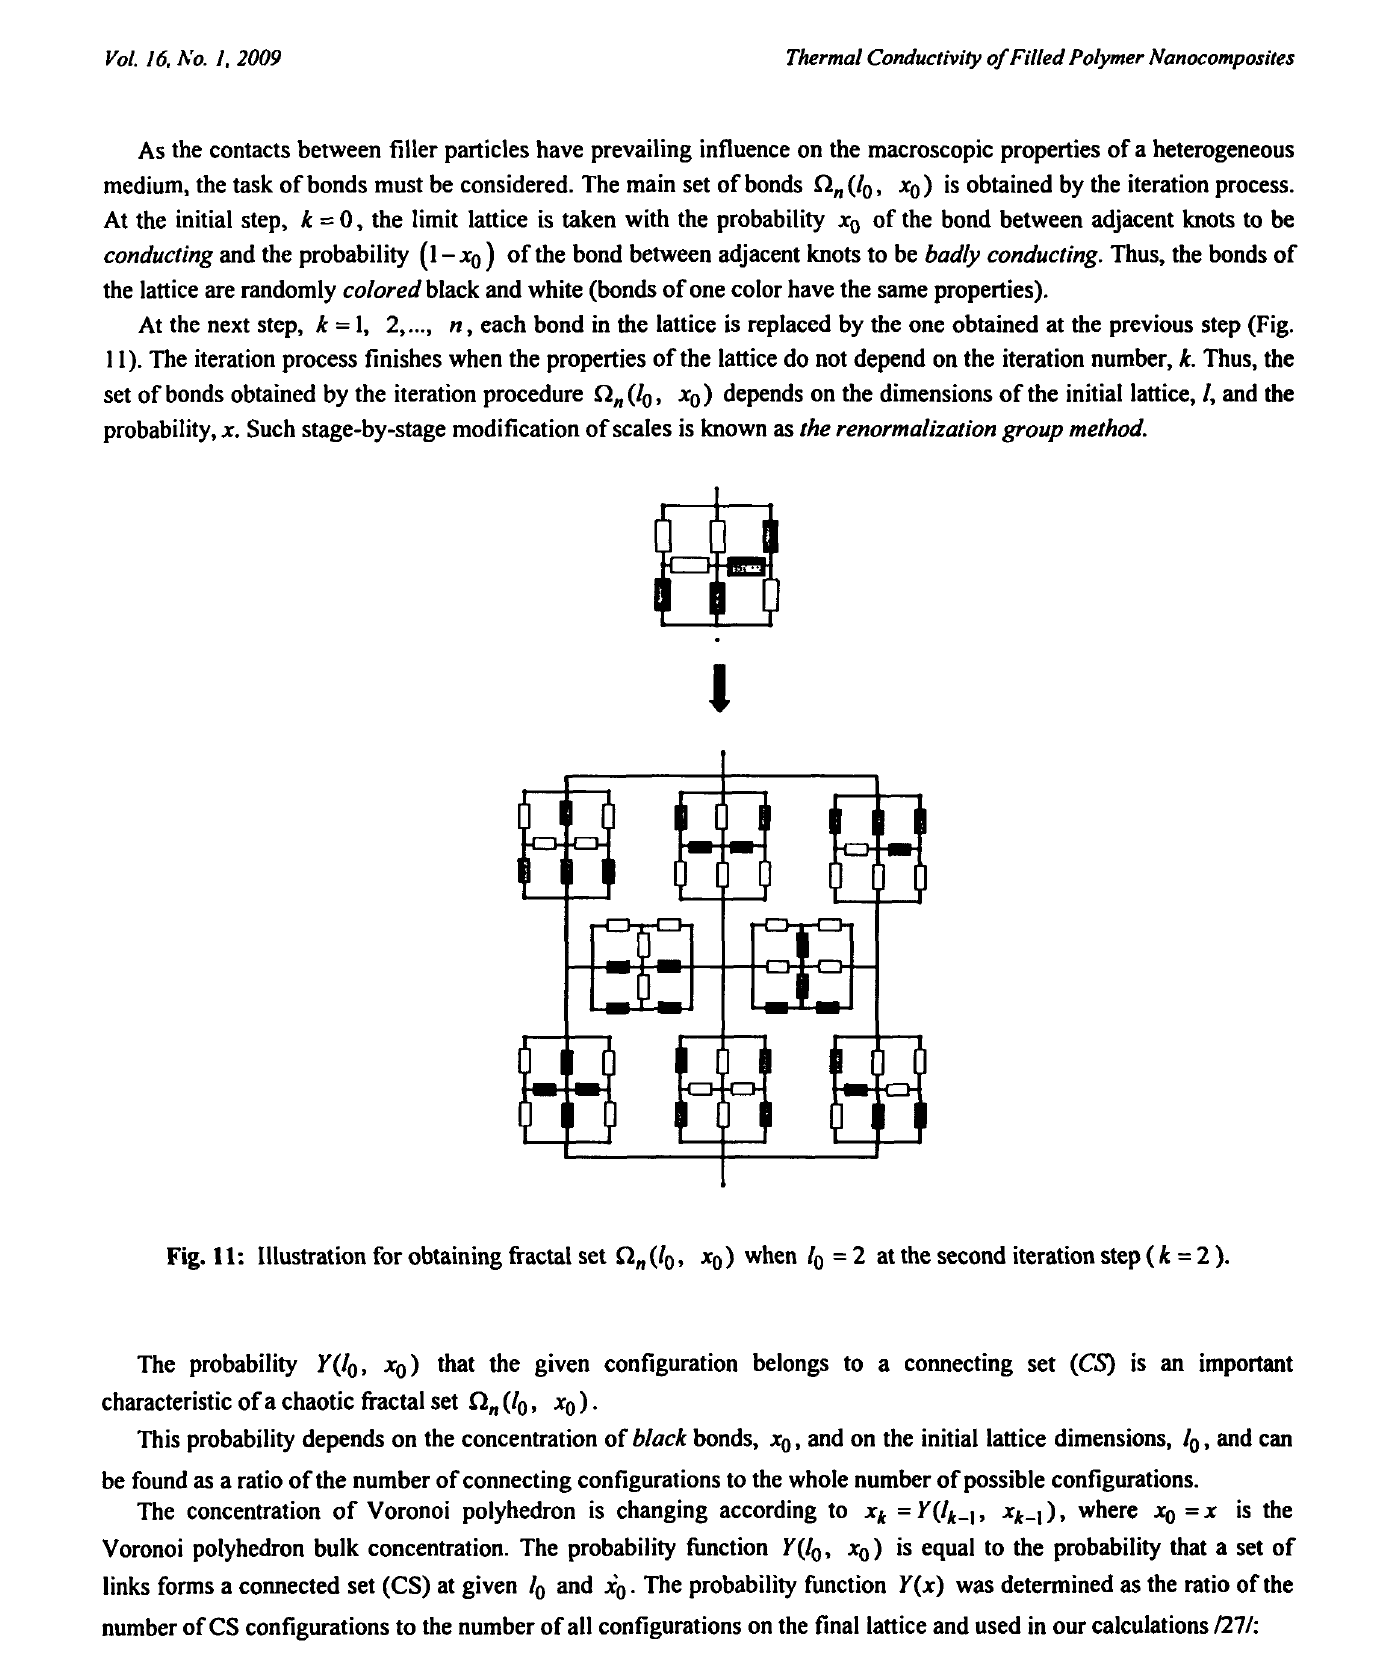
, XQ) that the given configuration belongs to a connecting set (CS) is an important 0 (/ , η 0